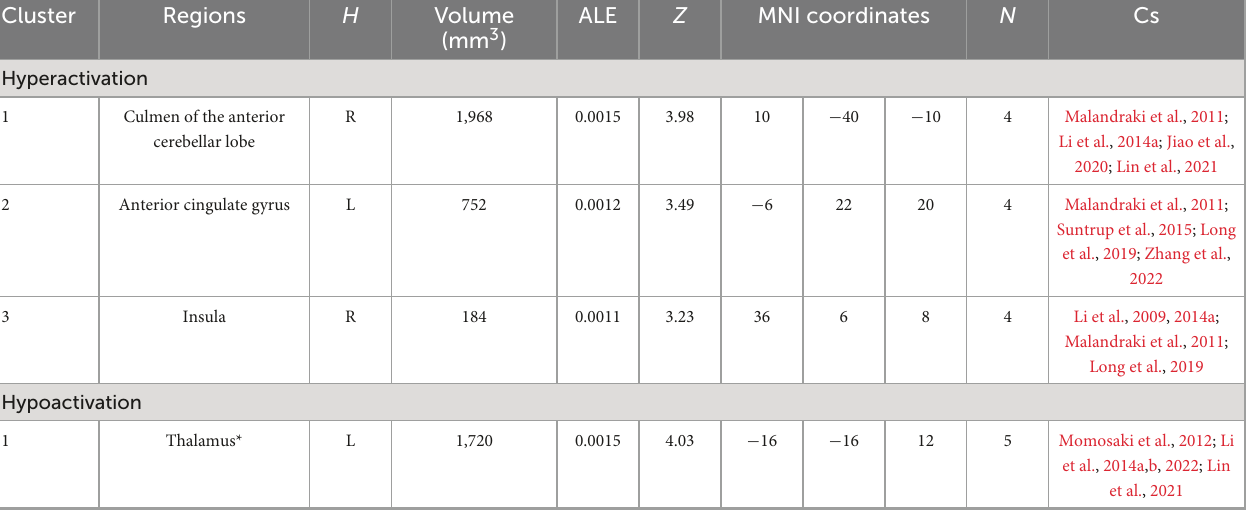
TABLE 5 Clusters of functional MRI activation likelihood estimation (ALE) meta-analyses.